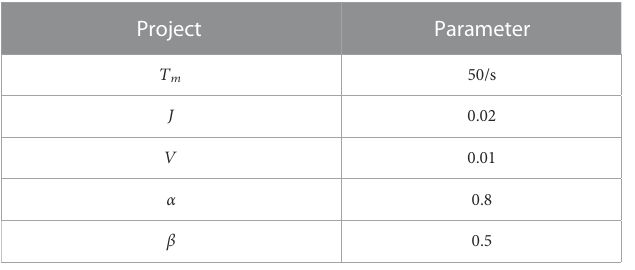
TABLE 1 Parameter setting of simulation experiment.